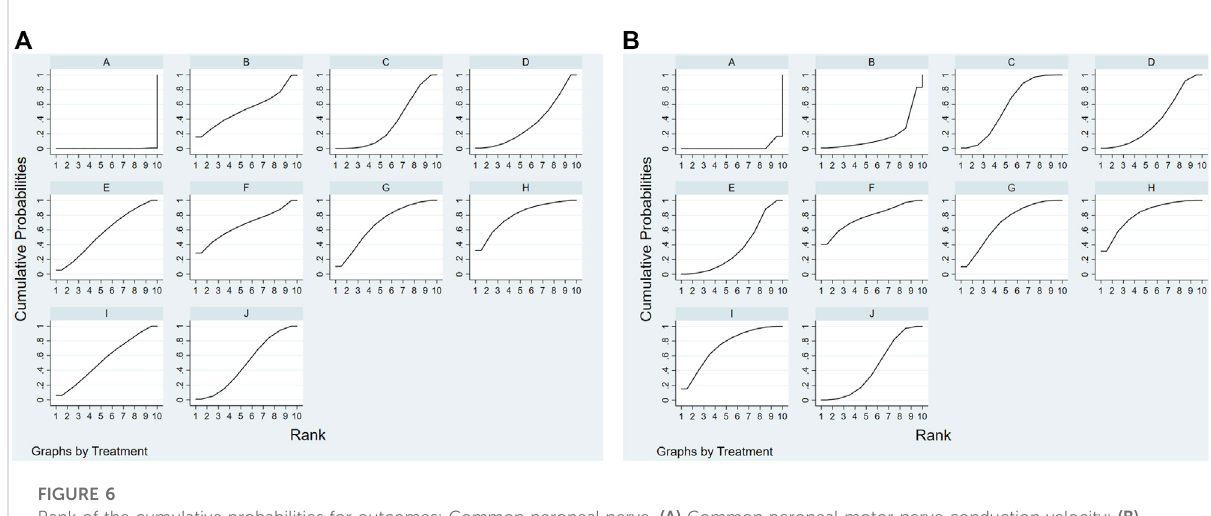
FIGURE 6 Rank of the cumulative probabilities for outcomes: Common peroneal nerve. (A) Common peroneal motor nerve conduction velocity; (B) common peronealsensorynerveconductionvelocity.[ (A) :ME; (B) ME+CXQ; (C) ME+DH; (D) ME+DSCXQ; (E) ME+ DZHS; (F) ME+DZXX; (G) ME + GGS; (H) ME + HH; (I) ME + KDZ; (J) ME + YXY].